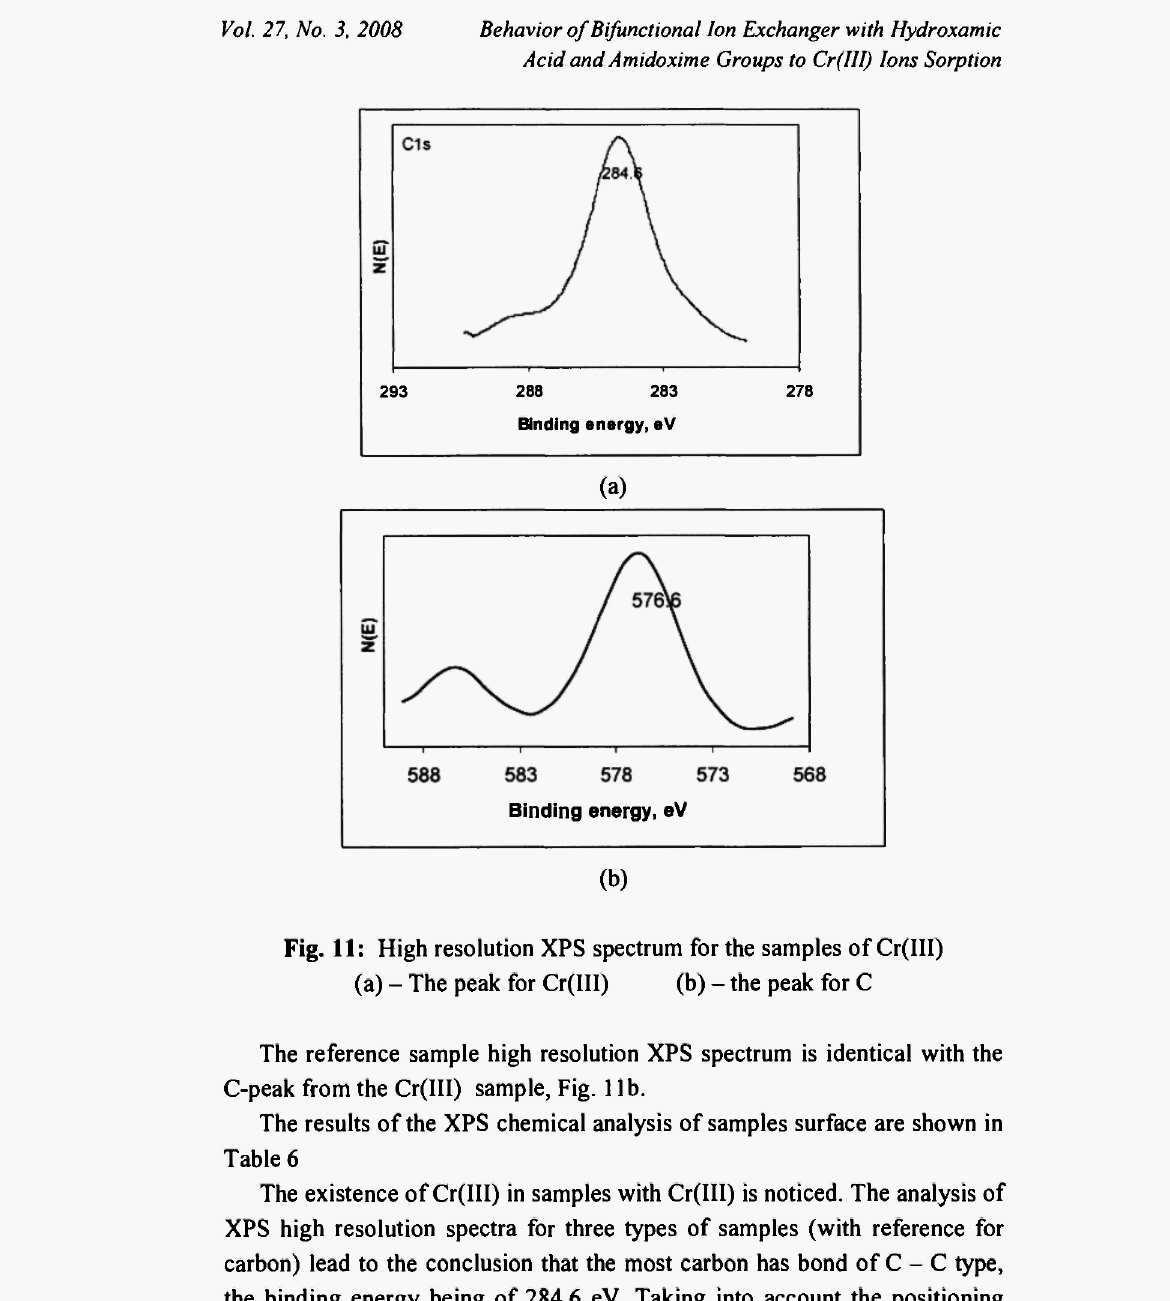
The existence of Cr(III) in samples with Cr(III) is noticed. The analysis of XPS high resolution spectra for three types of samples (with reference for carbon) lead to the conclusion that the most carbon has bond of C - C type, the binding energy being of 284.6 eV. Taking into account the positioning mode of peaks from XPS high resolution spectra for Cr(III) samples, it is obvious that the ions of Cr(III) are in the oxidized form, the binding energies being of 576.6 eV; the bond being of M +